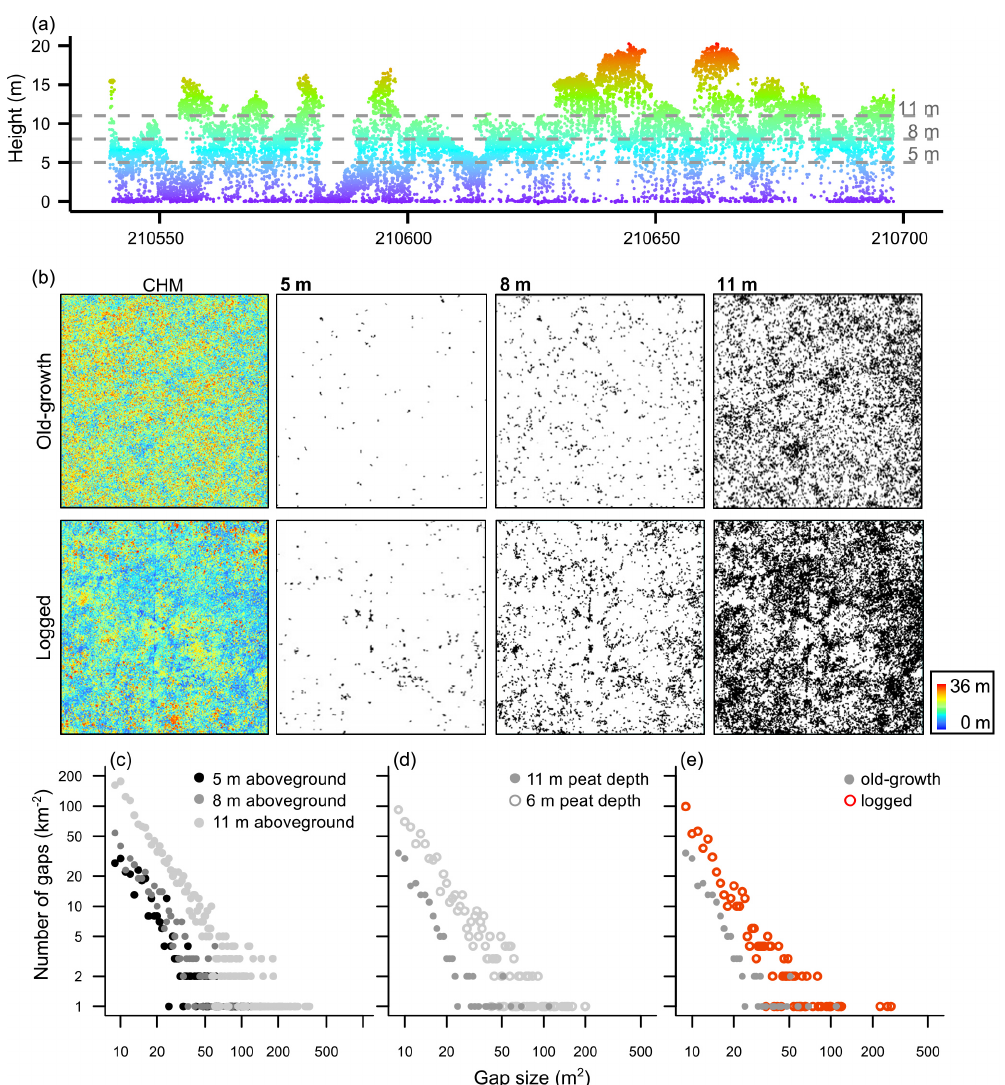
Figure 2. Detection of canopy gaps of a forest using airborne laser scanning (ALS) (a, b) and examples of gap size frequency distributions (GSFD) (c–e) . (a) ALS point cloud along a transect allows distinguishing emergent crowns and canopy gaps reaching to different heights above-ground. (b) Canopy gap detection in different cross-sections of the ALS-derived canopy height model (CHM) in an old-growth (top row) and a logged (bottom row) peat swamp forest plot (1km 2 ) . Columns to the right show canopy gaps ( ≥ 9m 2 ) as darkened areas in horizontal cross-sections of the CHM at 5, 8 and 11m above-ground. Examples of variation of the GSFD with (c) height above-ground, (d) peat depth and with (e) logging, both in the 8m cross-section. The number of gaps of a given size is given by the probability distribution multiplied by the total number of